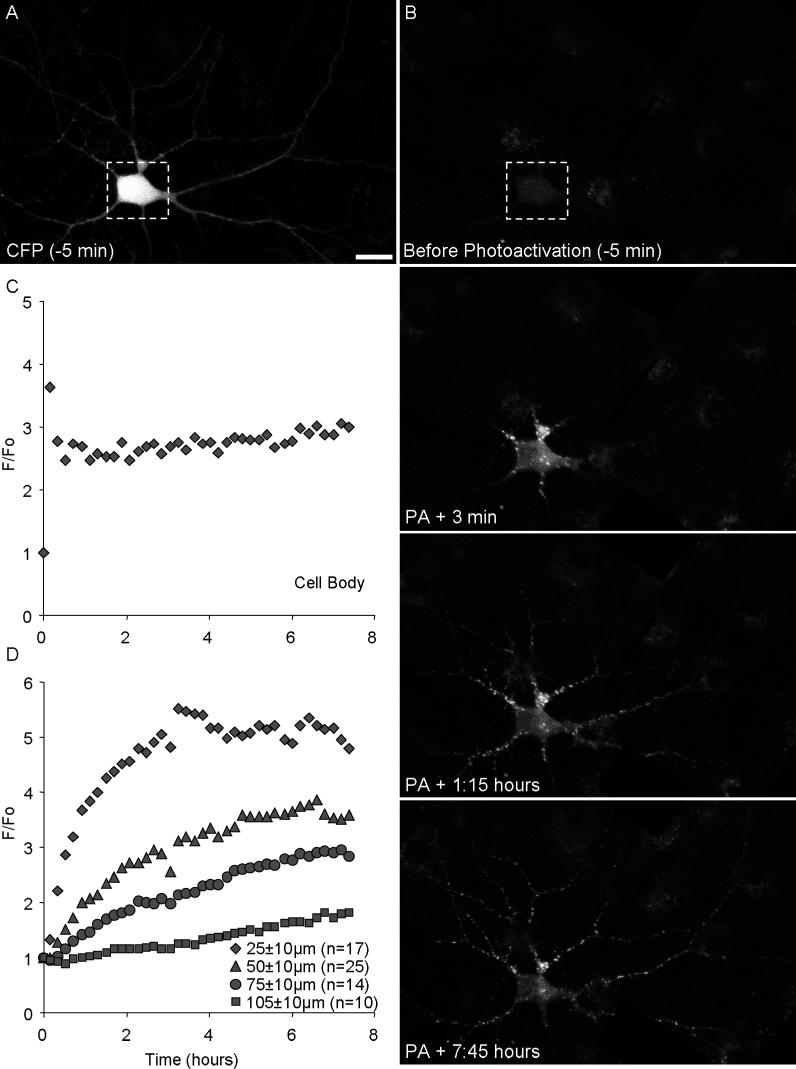
Incorporation Rates of ProSAP2 from Somatic Sources into Remote PSDs(A) Composite image of a neuron expressing CFP and PA-GFP:ProSAP2. Only CFP fluorescence is shown here.(B) PA-GFP:ProSAP2 fluorescence for same region as in (A). At time t = 0, PA-GFP:ProSAP2 within the cell body was photoactivated by selective illumination of the soma at 405 nm. With time, photoactivated PA-GFP:ProSAP2 migrated to PSDs along the dendrites, initially to proximal PSDs and later to more distal ones. During the time-lapse session, recurrent, low-level photoactivation of the soma was performed, to maintain a constant level of somatic, photoactivated PA-GFP:ProSAP2.(C) Quantification of fluorescence changes at the soma.(D) Quantification of fluorescence changes at PSDs, grouped according to distance from the soma. Fluorescence data for each PSD were normalized to prephotoactivation fluorescence levels for the same PSD. Bar, 20 μm.